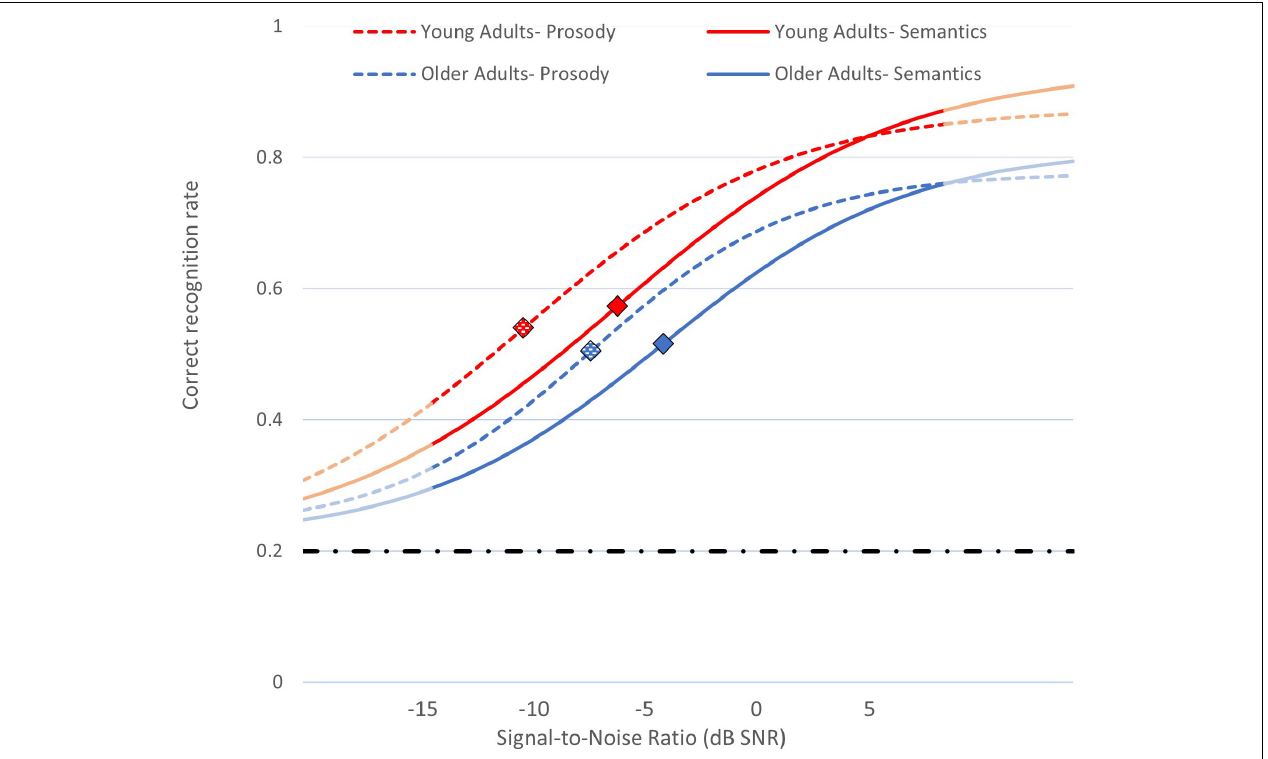
FIGURE 2 | Psychometric functions for recognition of emotions in speech in different SNRs, averaged across participants. Blue lines: older adults; red lines: young adults. Dashed lines: recognition of emotional prosody; full lines: recognition of emotional semantics. Diamond-shaped markers indicate statistical recognition thresholds for each condition. Light-blue and light-red lines represent extrapolations of the functions beyond the SNRs tested in the study. The dashed-and-dot horizontal line indicates the functions’ minimal asymptote (0.2 - chance level).